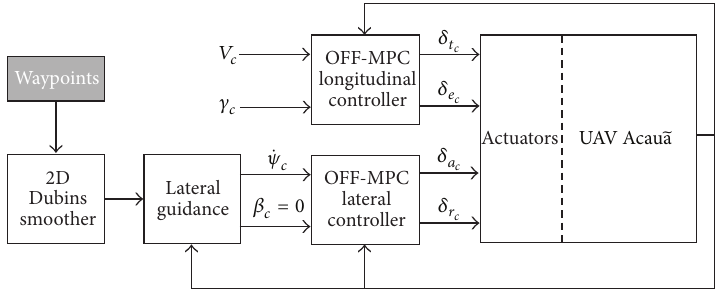
Figure 3: Closed-loop system for UAV trajectory